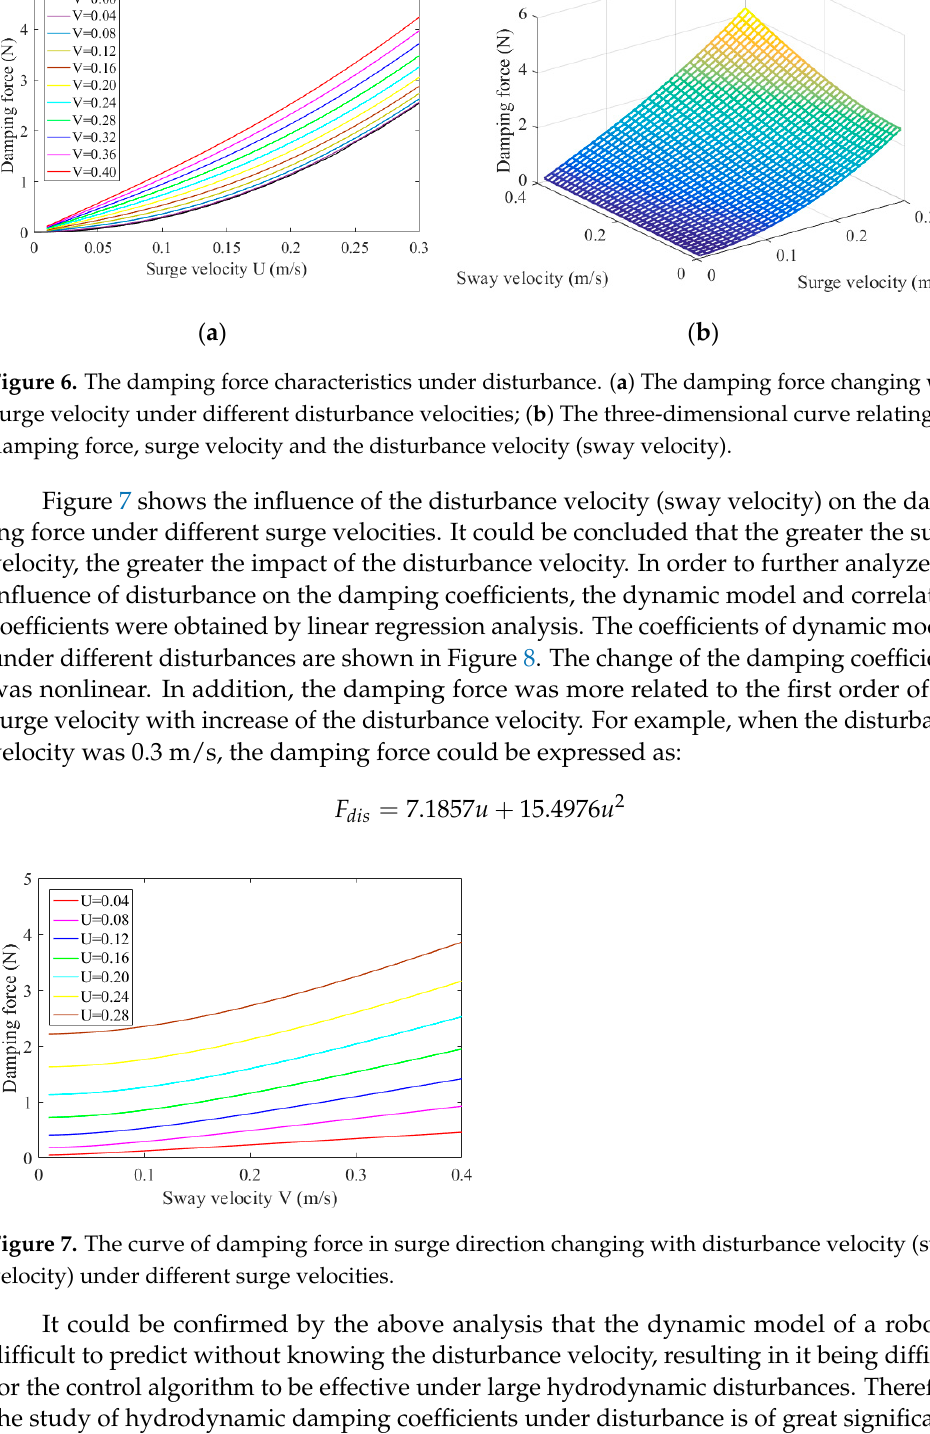
Figure 8. The relation between the damping coefficients of surge motion and the disturbance velocity in sway direction. It could be confirmed by the above analysis that the dynamic model of a robot is difficult to predict without knowing the disturbance velocity, resulting in it being difficult for the control algorithm to be effective under large hydrodynamic disturbances. Therefore, the study of hydrodynamic damping coefficients under disturbance is of great significance to develop better resistance of underwater robots to disturbance and to ensure better movement of the robots in complex current environments. 4. Experimental Evaluation and Discussion 4.1. Validation of Numerical Model In order to verify the correctness of the numerical simulation method used in this paper, the classical simulation, where water flows around a cylinder, was carried out in a three-dimensional environment. The cylinder diameter D was set as 20 times the lattice length. The flow diagrams near the cylinder under the Reynolds number Re = 40 and Re = 100 were obtained, as shown in Figure 9. Relevant verification parameters were calculated and compared with others’ experimental data, as shown in Table 1. The difference between the simulation results and others’ results was small, which proved the correctness of the simulation method. ( a ) ( b ) Figure 9. The flow field and streamline around a cylinder. ( a ) Re = 40; ( b ) Re = 100.